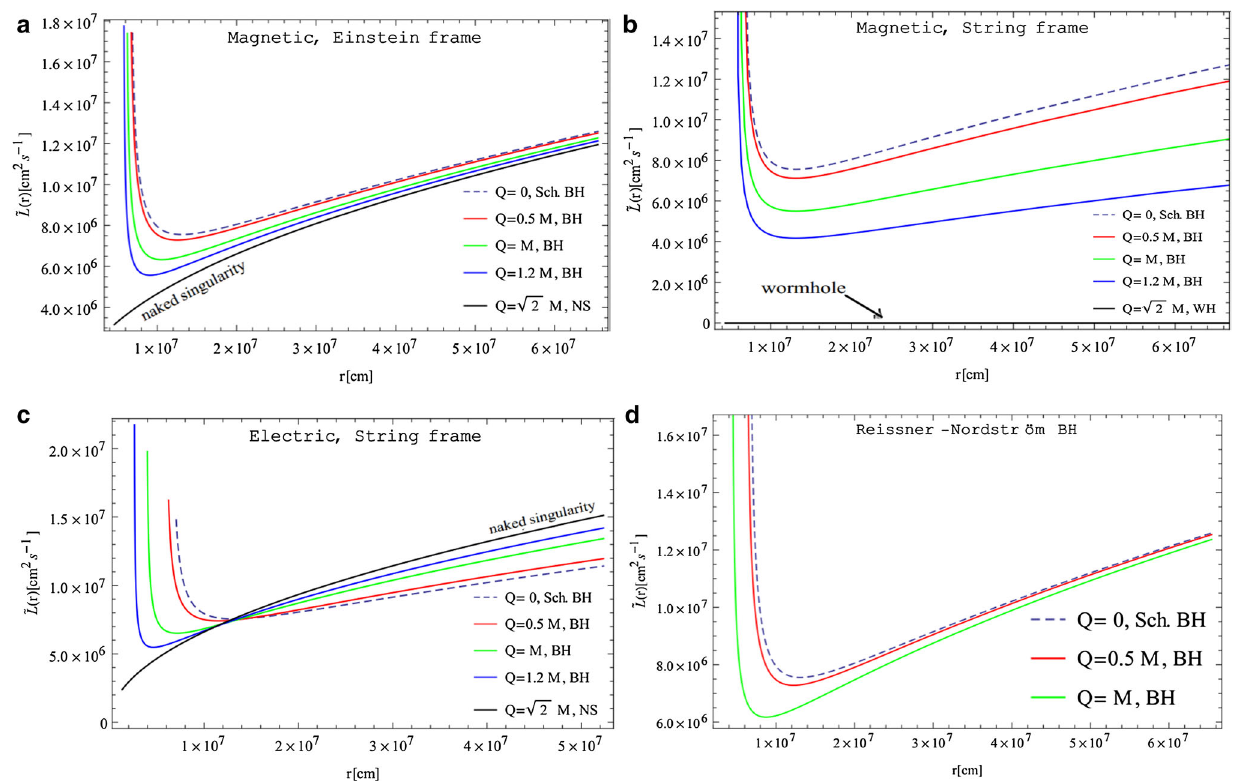
Fig. 2 The specific angular momentum ˜ L ( r ) of the orbiting particle as a function of the radial coordinate r (in cm) for a GMGHS BH in EF ( a ), magnetically charged in the SF ( b ), electrically charged in the SF ( c ) and Reissner–Nordström BH ( d ) plotted for different values of Q .